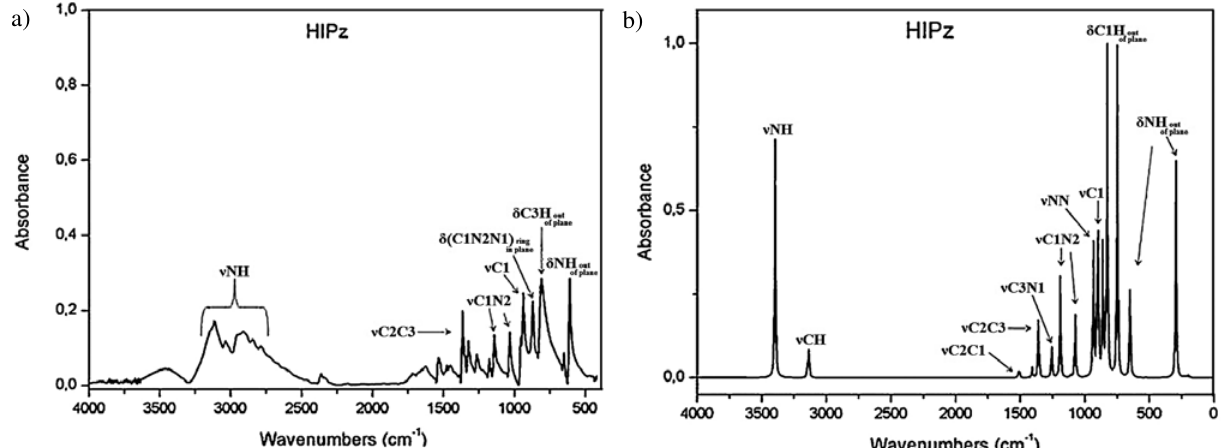
Figure 3. Experimental (a) and theoretical (b) IR spectra of the